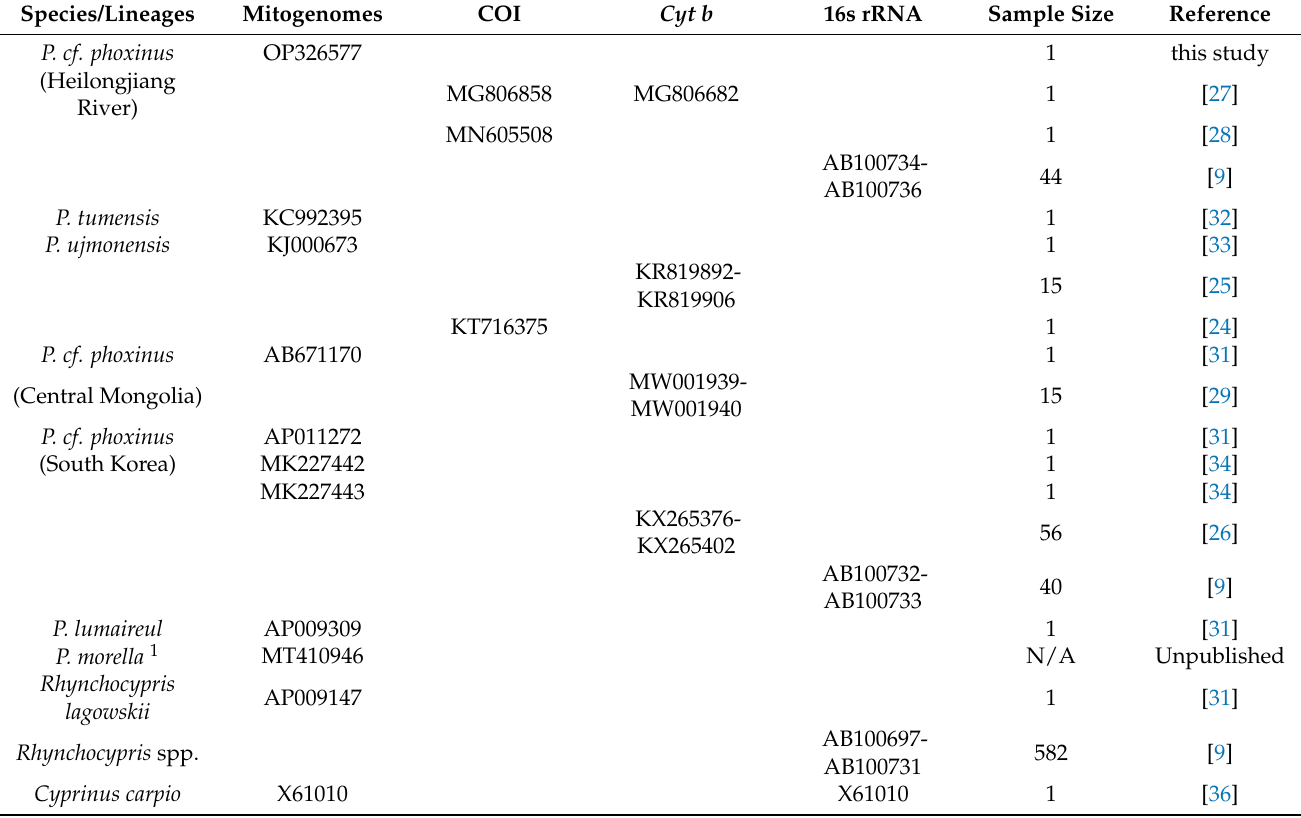
Table 1. The samples used for phylogenetic analysis and accession numbers of their mtDNA